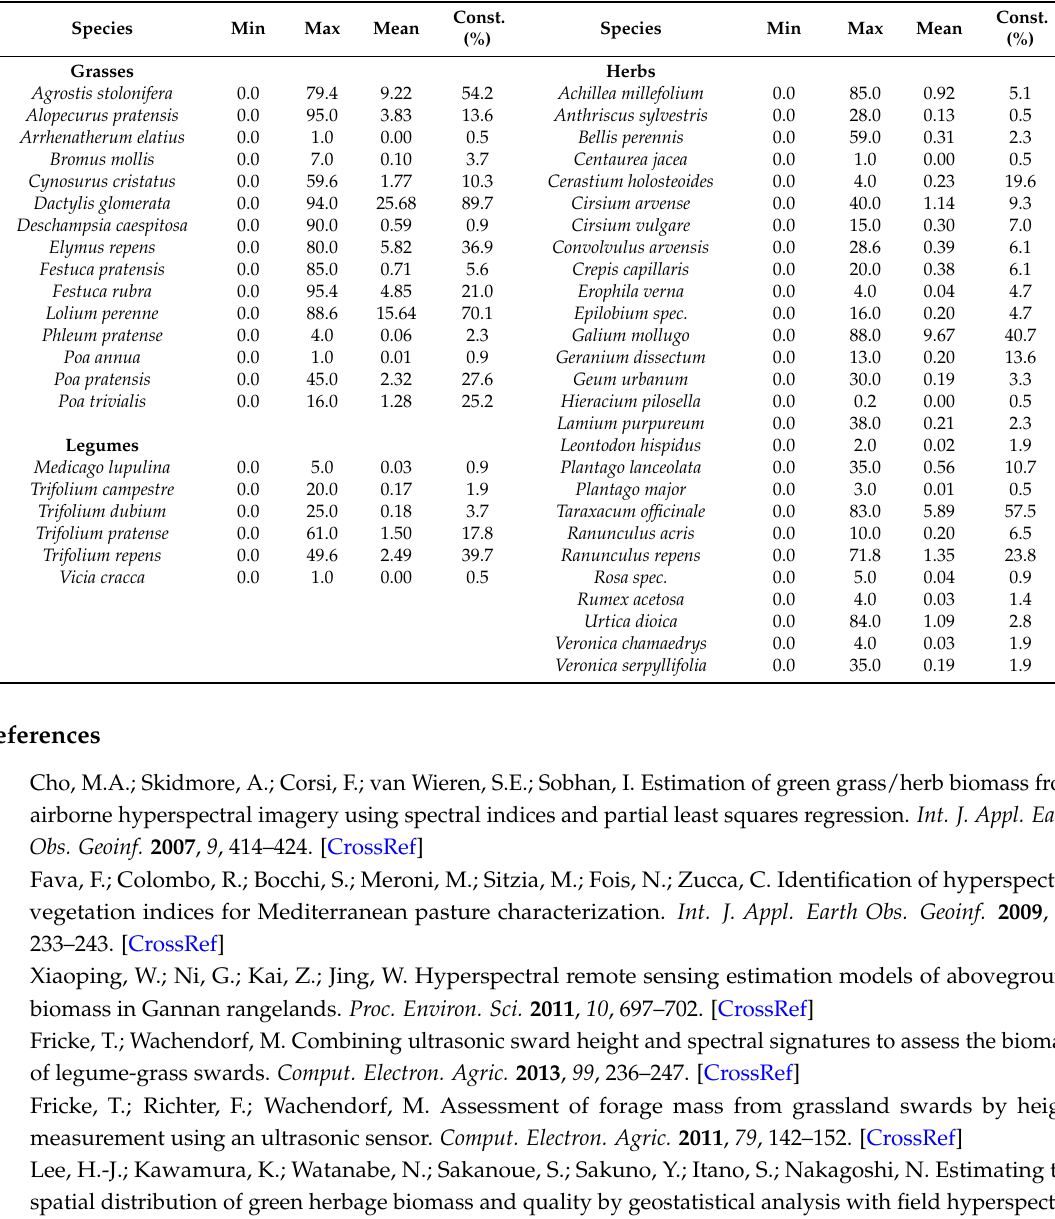
Table A1. List of pasture species identified in 214 sampling plots in 2013 with their minimum, maximum and mean values of dry matter contribution estimated according to the Klapp and Stählin method. Constancy (Const.) refers to the relative proportion of plots containing the respective